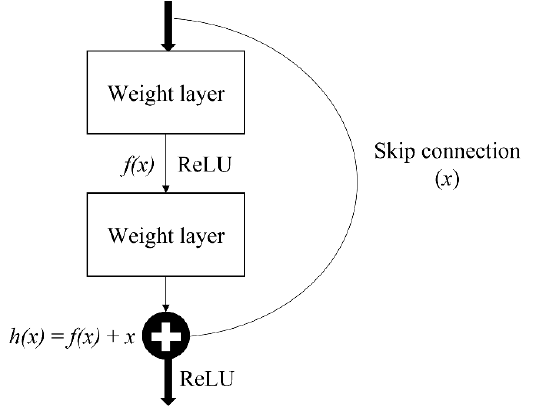
Figure 6. Single residual block.